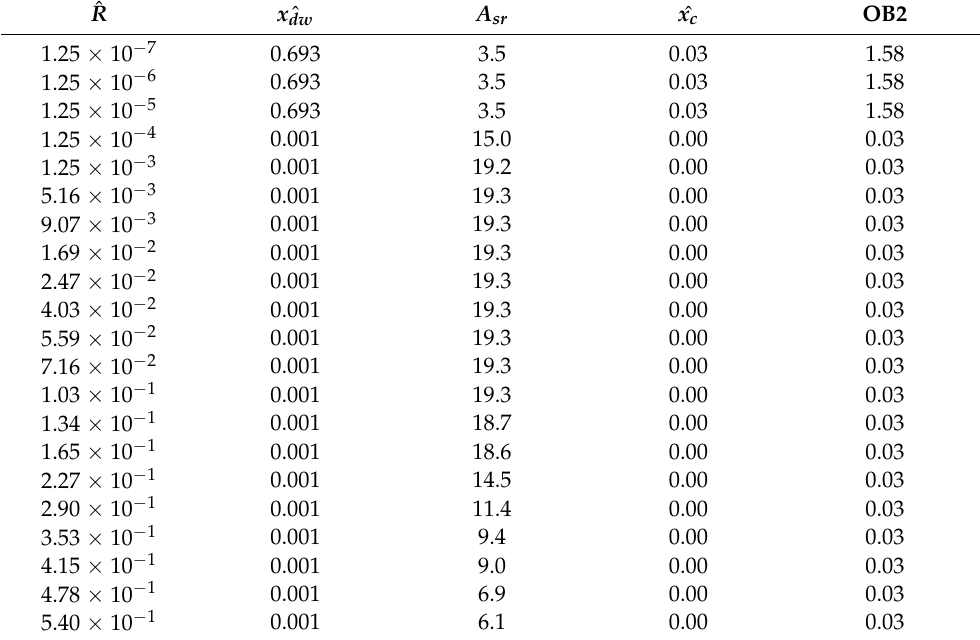
Table 2. Optimized dimensionless parameters for an RPSPV system using an objective function of Equation (35) at the downstream